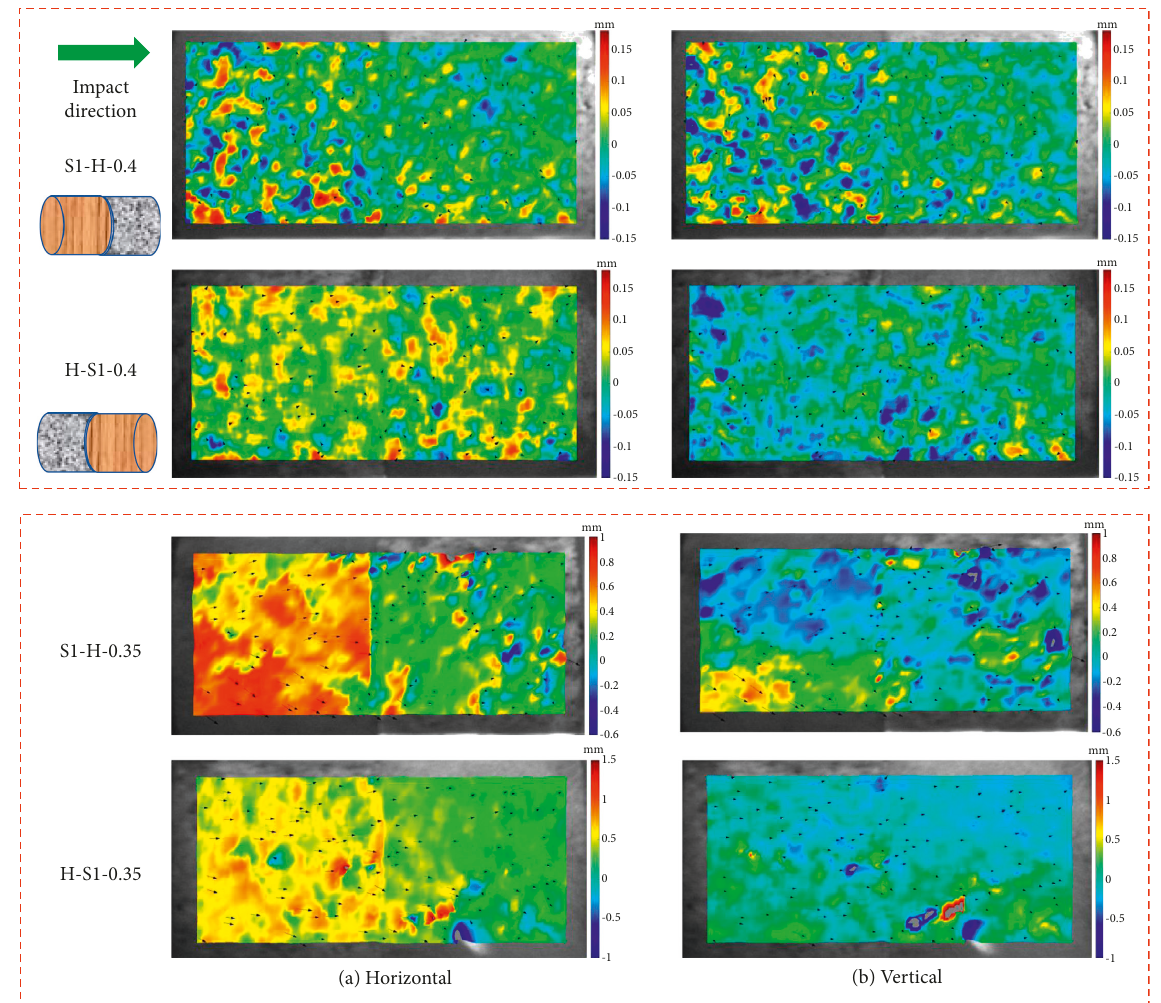
Figure 11: (a) Horizontal and (b) vertical displacement fields of composite samples